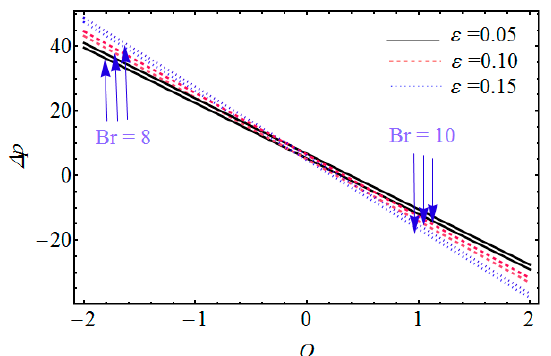
Figure 5. Variation of pressure rise ∆𝑝 with 𝛿 and 𝐺𝑟 for fixed 𝜃 = 0.8, 𝜑 = 0.1, 𝜀 = 0.1, 𝐵𝑟 = 0.2, 𝑁𝑏 = 0.5, 𝑁𝑡 = 0.2, 𝜆 (cid:2869) = 5, 𝑉 = 0.1, 𝑡 = 0.05.